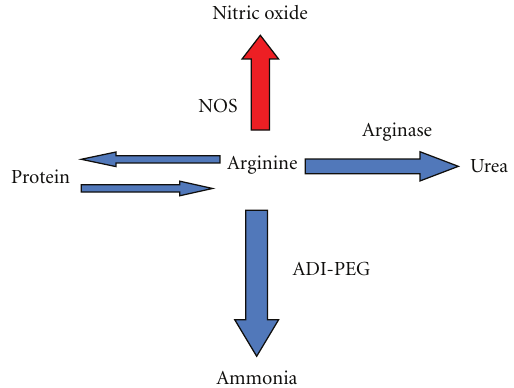
Scheme 1: Arginine